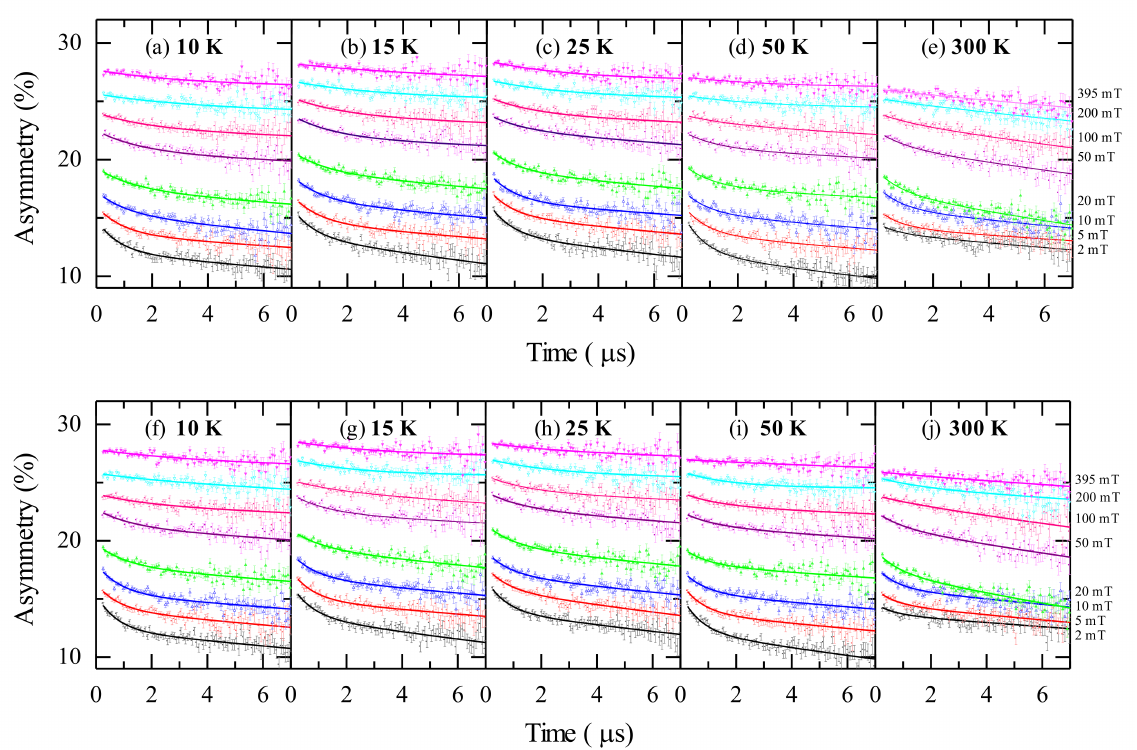
Figure 2. The asymmetry data for regio-regular P3HT–ZnO nanoparticles for various applied longitudinal fields without light irradiation at temperatures of ( a ) 10 K, ( b ) 15 K, ( c ) 25 K, ( d ) 50 K, and ( e ) 300 K, and with light irradiation at temperatures of ( f ) 10 K, ( g ) 15 K, ( h ) 25 K, ( i ) 50 K, and ( j ) 300